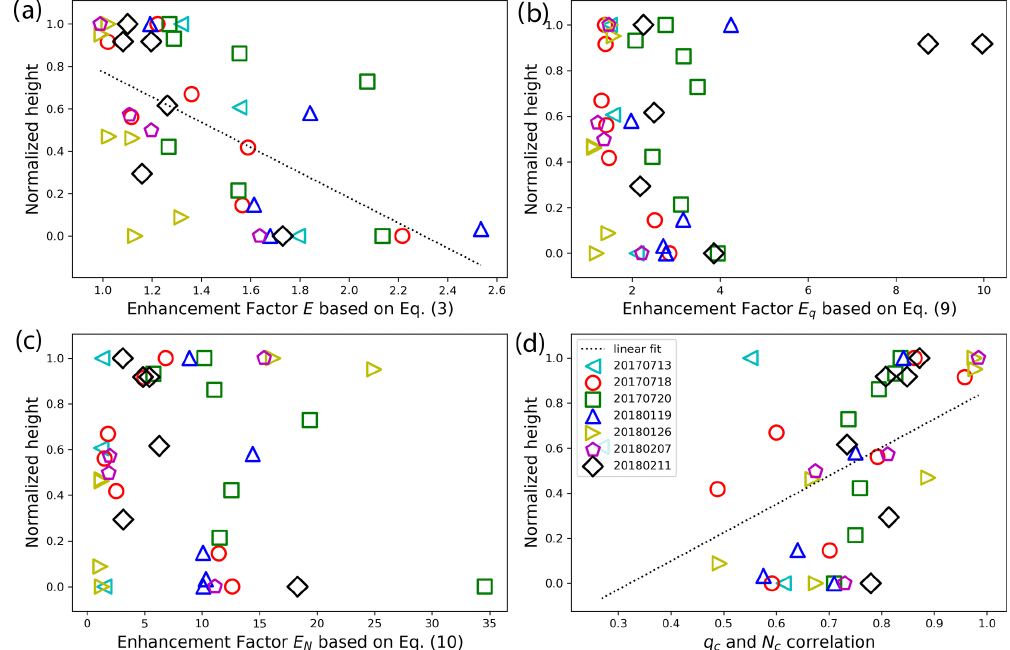
Figure 8. (a) The observation-based E derived from Eq. (3) that accounts for the covariation of q c and N c . (b) The observation-based E q derived from Eq. (9) that accounts for only the subgrid variation of q c . (c) The observation-based E N derived from Eq. (10) that accounts for only the subgrid variation of N c . (d) The correlation coefficient between q c and N c . All quantities are plotted as a function of the normalized height z ∗ in Eq. (11). The dashed lines correspond to a linear fit of the data when the fitting is statistically significant (i.e., P value < 0.05). hleg